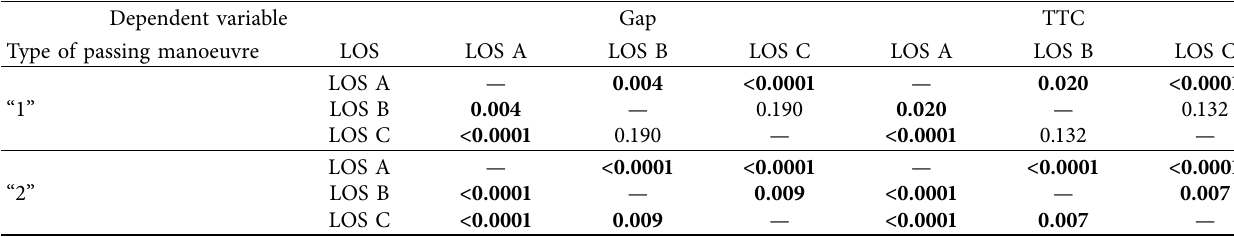
Table 9: Results of the pairwise comparison test ( P value) for the LOS factor.